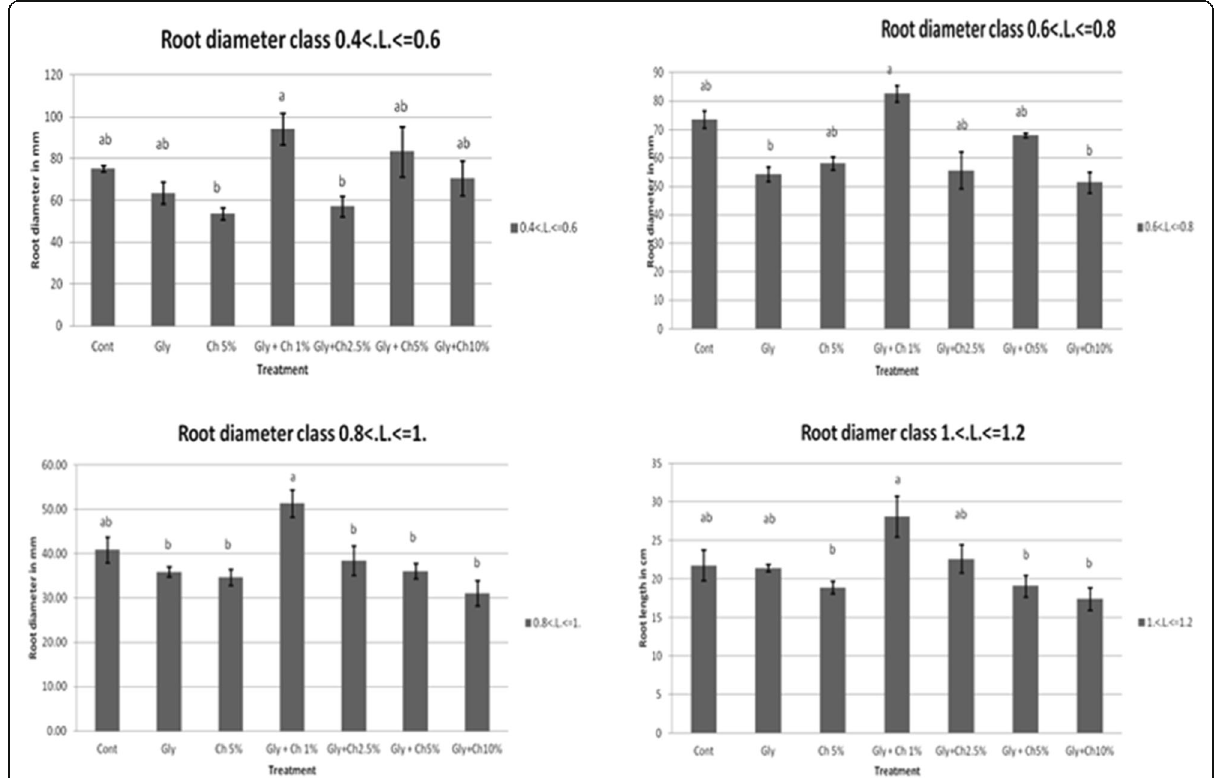
Fig. 6 Root length of winter wheat seedlings (cv. Isengrain) of different treatments 14 days after seeding in the diameter ranges 0.4 – 0.6 mm, 0.6 – 0.8 mm, 0.8 – 1 mm and 1 – 1.2 mm. Data show average treatment values of four independent replicates. Treatment letters were as follows: Cont= pure soil without glyphosate, Gly = glyphosate 6 L dose without biochar amendment, ch5% = biochar amendment of 5%, gly6L + ch1% = glyphosate with biochar amendment of 1%, Gly6L + ch2.5% = glyphosate with biochar amendment of 2.5%, Gly6L + ch5% = glyphosate with biochar amendment of 5%, and gly6L + ch10%= glyphosate with biochar amendment of 10%. Error bars indicating standard error. Different letters above the bars indicating significant differences ( α =